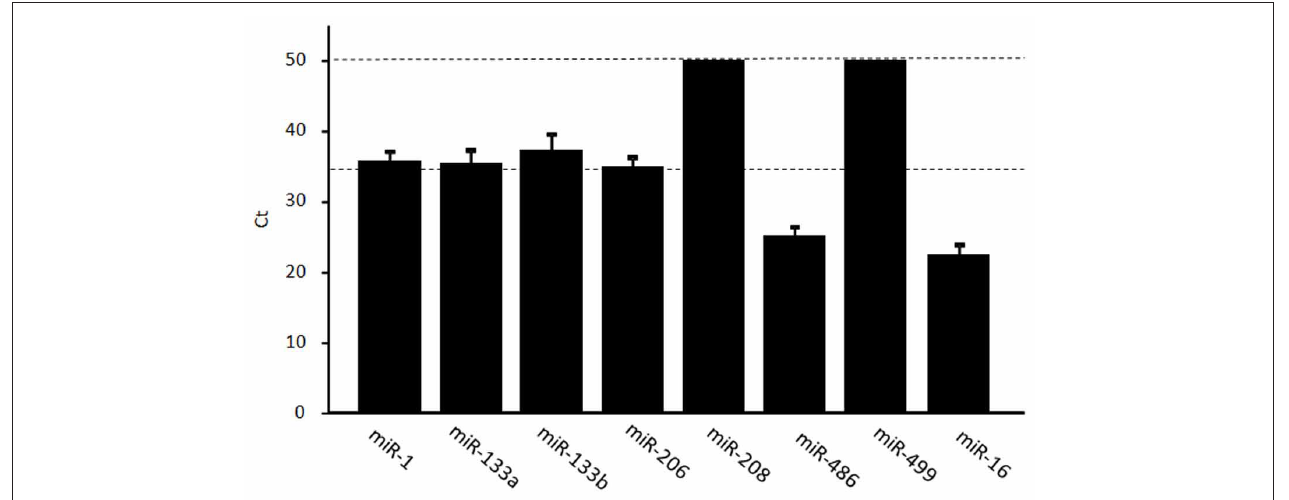
FIGURE 1 | Levels of muscle-enriched miRNAs in serum. The levels of muscle-enriched miRNAs (miR-1, miR-133a, miR-133b, miR-206, miR-208b, miR-486, and miR-499) and miR-16 in serum were measured using